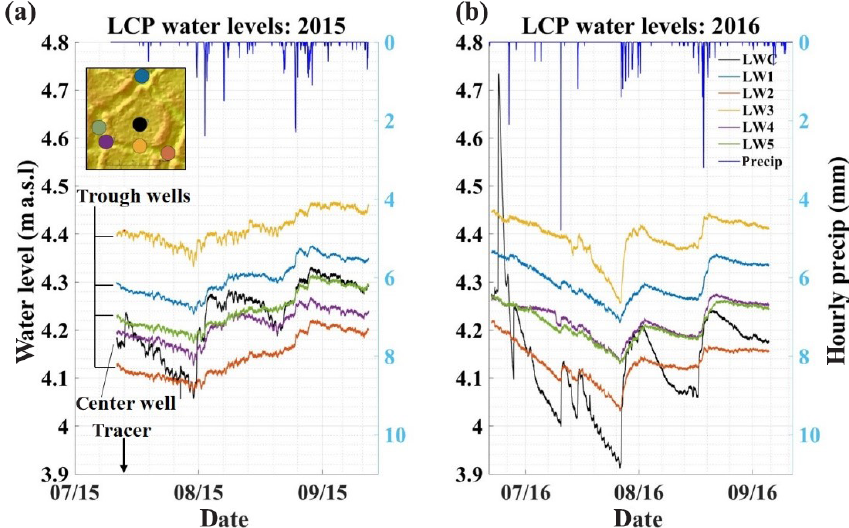
Figure 6. Water levels from the low-centered polygon (LCP) for the 2015 (a) and 2016 (b) thaw seasons. Arrow indicates date of tracer application. Dots in the inset (upper-left) correspond to observation-well locations; colors of the dots correspond to well hydrographs. Dark blue lines along the top of the graphs indicate hourly total precipitation.